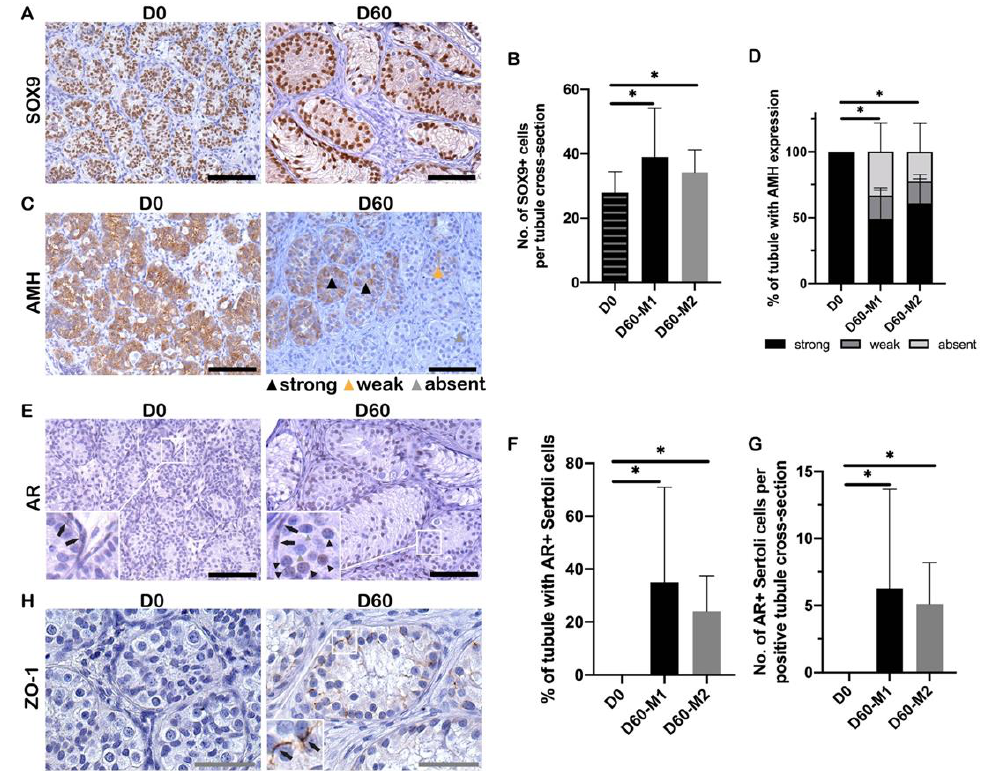
Figure 3. Sertoli cell survival, maturation, and functionality. ( A ) SOX9 positive staining within ITT at D0 and D60. ( B ) The number of SOX9+ Sertoli cells per tubule before and after 60-day organotypic culture. ( C ) AMH positive staining within ITT at D0 and D60. Black triangle: strong staining of AMH; orange triangle: weak staining of AMH; grey triangle: absent staining of AMH. Scale bar = 100 µ m. ( D ) Percentage of tubules with immunohistochemical staining of AMH. The staining of AMH was evaluated by a semiquantitative score according to the staining color intensity—absent, weak, and strong. The percentage of “strong” AMH tubules showed a significant decrease in both media at D60 compared to D0 (M1: p < 0.001, M2: p < 0.001), the similar result for “weak” AMH tubules (M1: p < 0.001, M2: p < 0.001). No significant difference was observed between the two culture media. Scale bar = 100 µ m. ( E ) AR staining within ITT at D0 and D60. Black arrowhead: AR-positive Sertoli cells; grey arrowhead: AR-negative Sertoli cells; black arrow: AR-positive peritubular myoid cells (PTMCs). Scale bar = 100 µ m. ( F ) Percentage of tubules with AR-positive Sertoli cells (positive tubule) within ITT. ( G ) The number of AR-positive Sertoli cells per positive tubule. ( H ) ZO-1 staining within ITT at D0 and D60. The black arrow indicated ZO-1 positive expression. Scale bar = 50 µ m. Asterisks indicated statistically significant